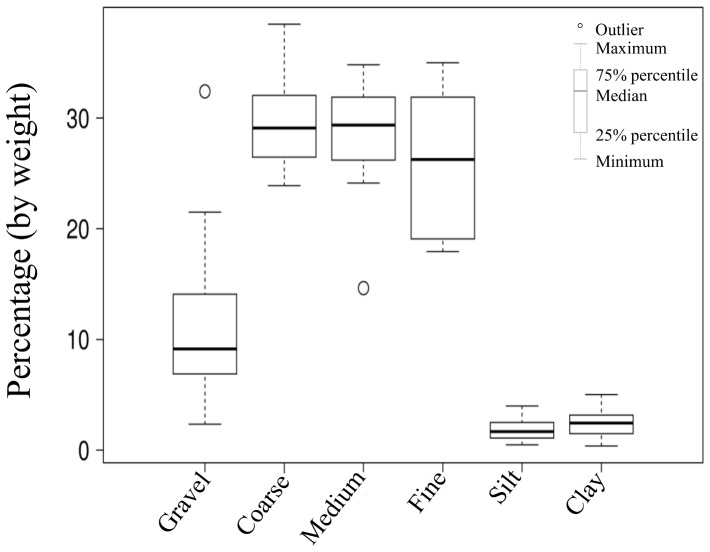
Boxplots showing the interquartile range (first quartile, median and third quartile) of the sediment data.Whiskers: the values that extend to 1.5 times the interquartile range. When there are no outliers the whiskers show the maximum and minimum values.